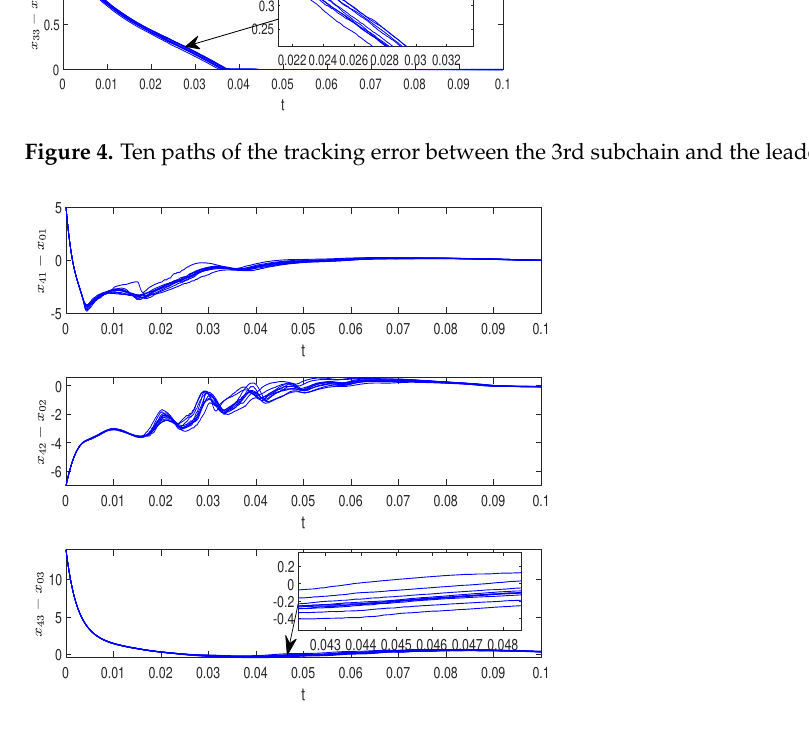
Fig.4. 10 paths of the tracking error between the 3-th subchain and the leader with protocol (4.2).